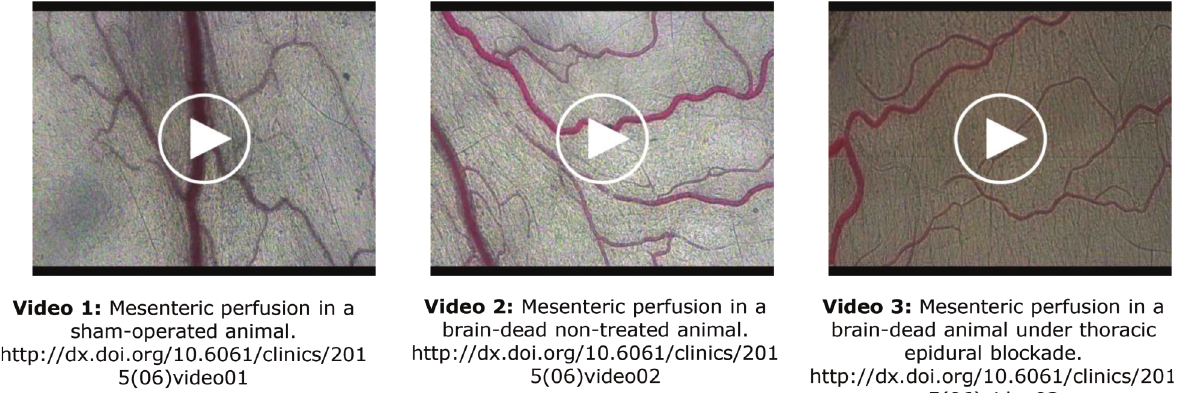
Figure 2 - Intravital microscopy of the rat mesenteric microcirculation. A, The percentages of perfused small vessels ( o 30 m m) in sham-operated rats (SH), brain-dead non-treated rats (BD), and brain-dead rats under thoracic epidural blockade (BD-TEB) 180 min after the surgical procedures. The data are presented as the means ± SEM; p ANOVA=0.002; * p o 0.05 vs. the other groups. B, C, and D, Photomicrographs of mesenteric microvessels in the SH, BD, and BD-TEB groups, SH rats, the mean arterial pressure did not change over time (Figure 1). There were no significant differences in the arterial blood gas, electrolyte, or lactate levels between the groups (data not shown).